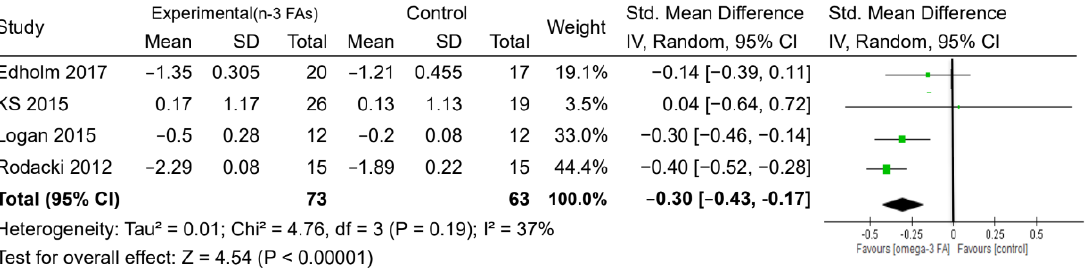
Figure 5. Forest plot of the effect of n-3 PUFA supplementation on the timed up and go test result. IV: inverse-variance method. Random, random effect. Weight (in %): the influence of an individual study on the pooled result.